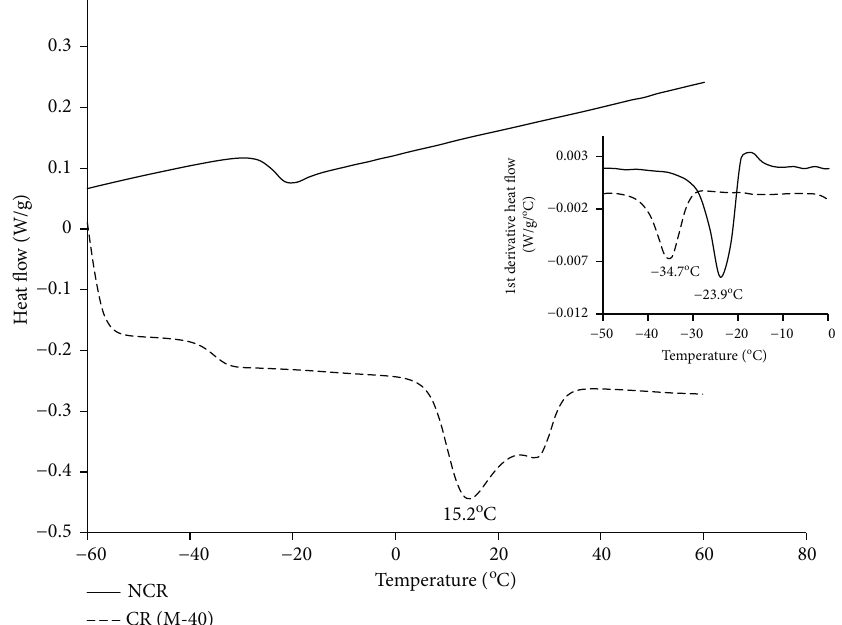
Figure 3: DSC results of acrylonitrile-chloroprene rubber (NCR) and chloroprene rubber (CR). The inset shows the 1st derivative plots in the glass transition